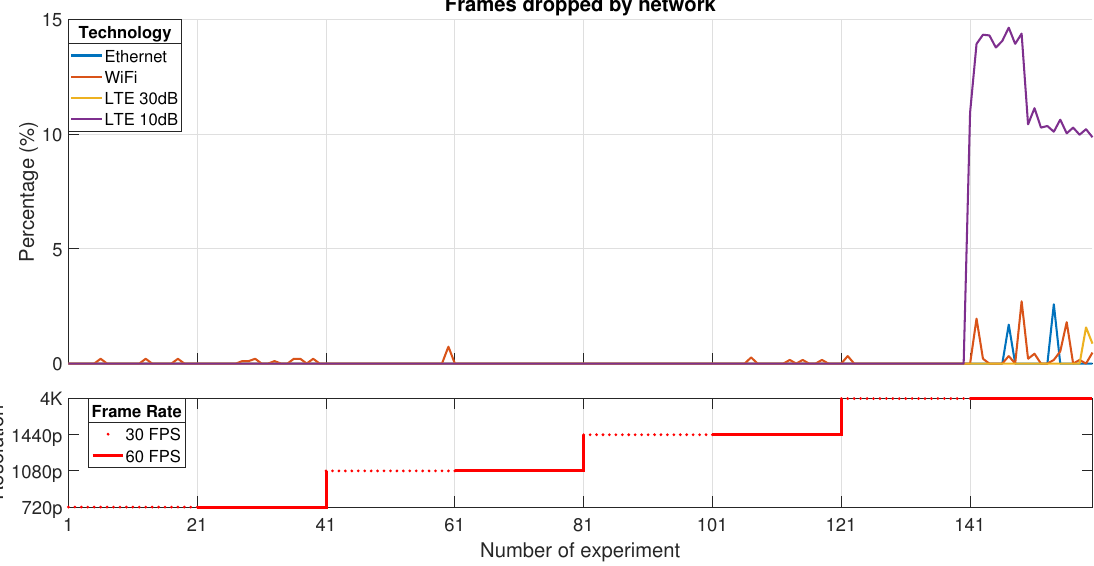
Figure 9. Frames dropped by